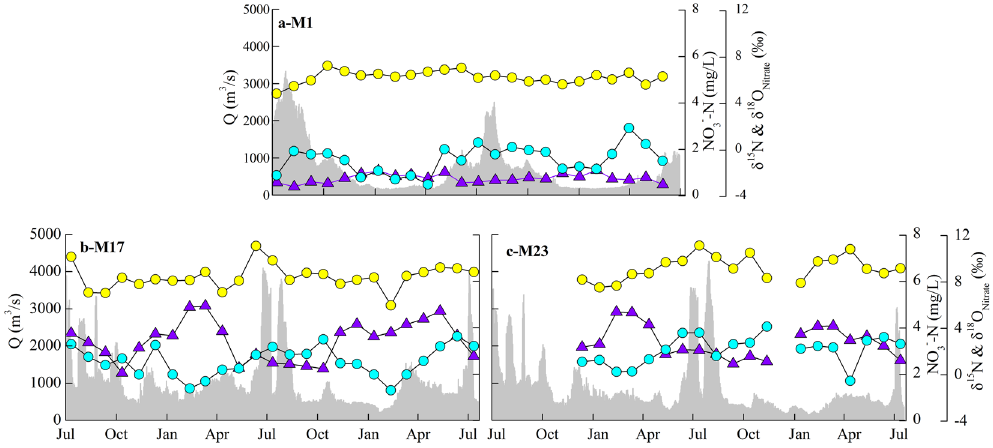
Figure 3. The variations of nitrate characteristics in monthly samples (symbols are same to Fig.